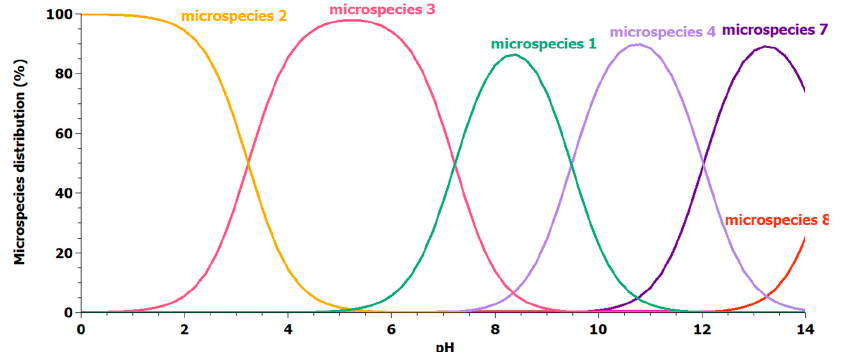
Figure 2. Speciation of AMX as a function of pH in aqueous solutions. The chemical structure of each microspecies is shown in the Supplementary Materials (Figures S1–S8). microspecies is shown in the Supplementary Materials (Figures